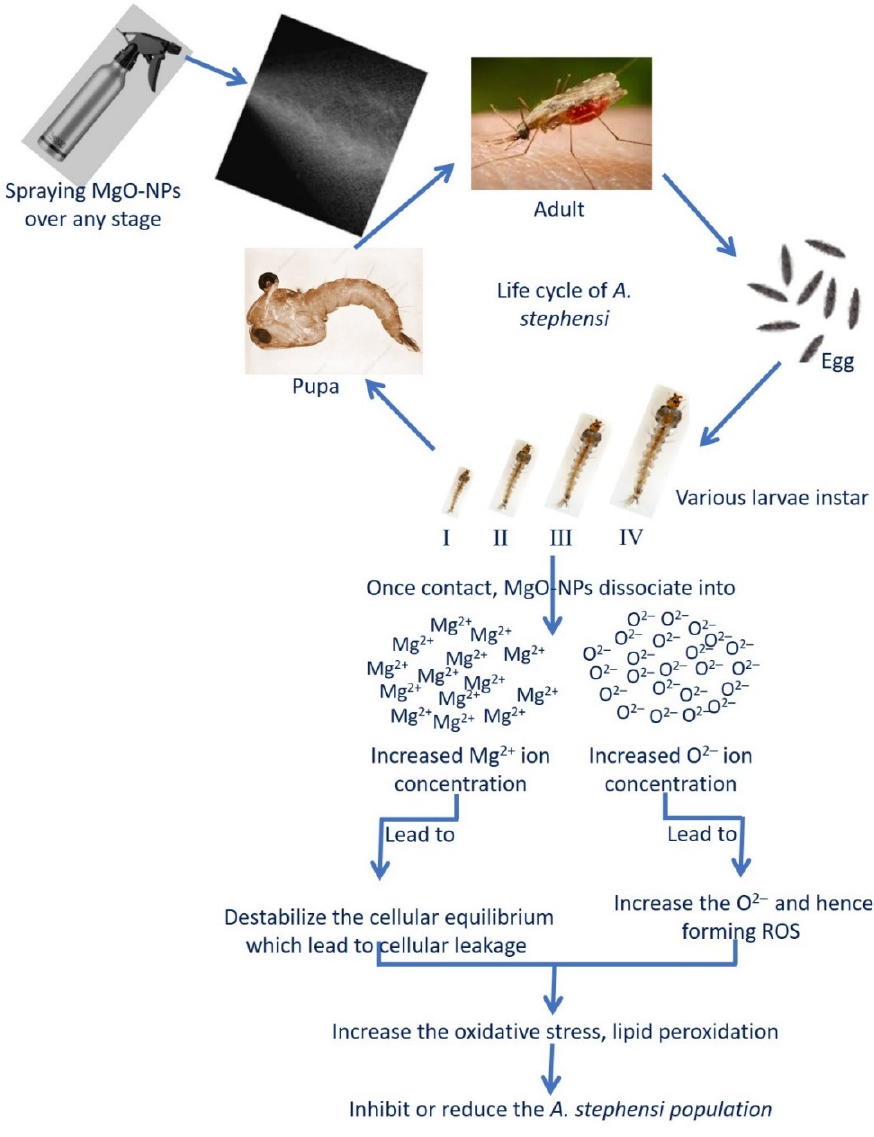
Figure 6. Prospective mechanisms of biosynthesized MgO-NPs as a mosquitocidal agent.